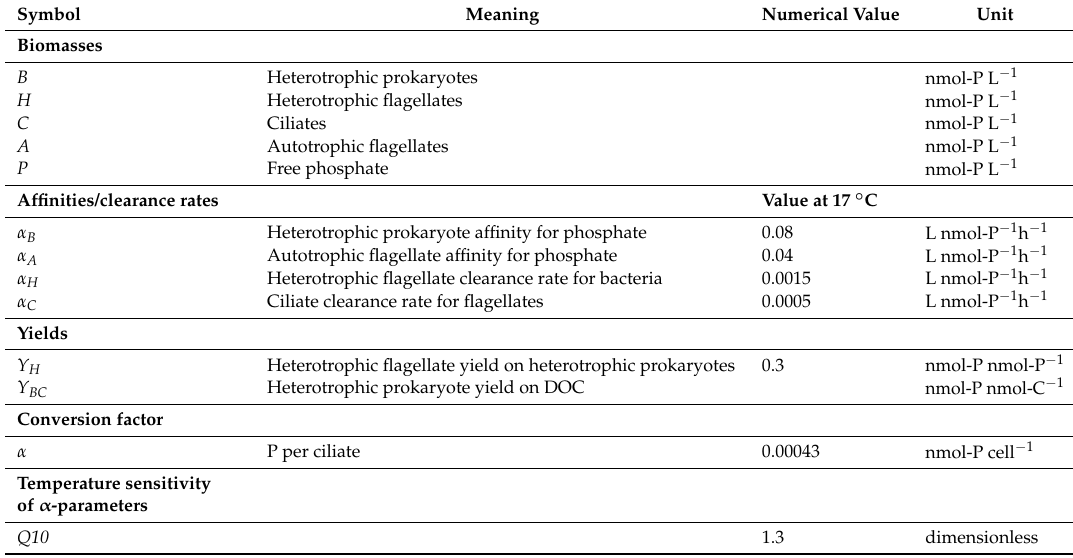
Table 1. Symbols and parameter values used in drawing Figure